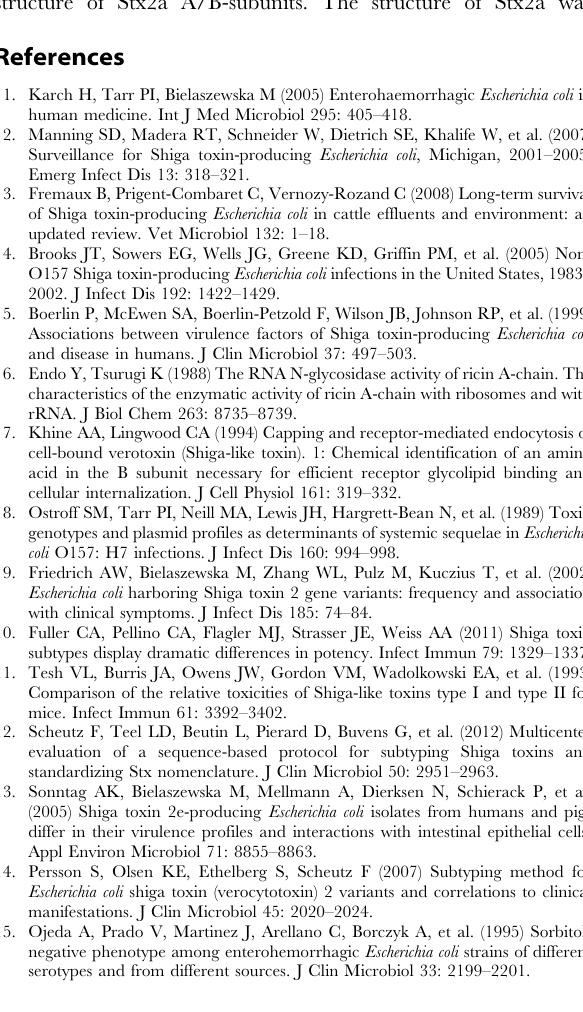
Figure S1 In silico mapping of Stx2-pAb epitopes to the 3-D structure of Stx2a A/B-subunits. The structure of Stx2a